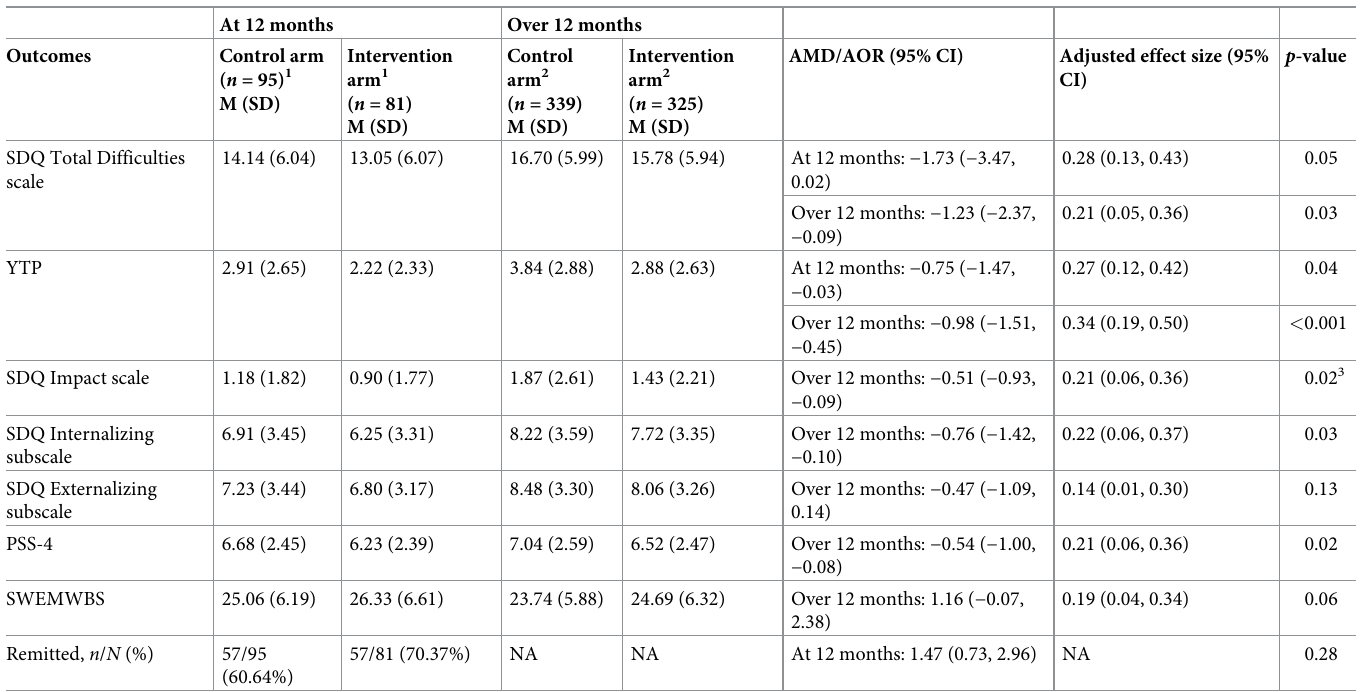
Table 2. Primary and secondary outcomes for 12 months follow-up. At 12 months